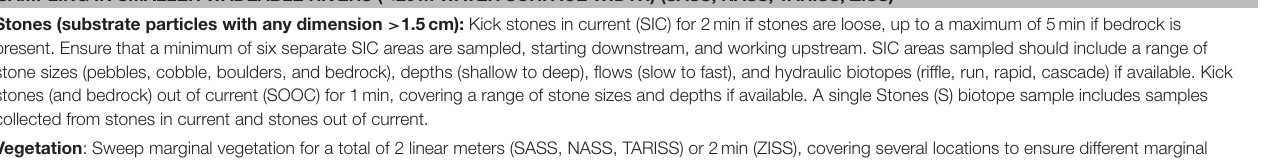
TABLE 1 | Standardized rapid bioassessment protocol for rivers based on aquatic macroinvertebrates used for South African Scoring System (SASS), Namibian Scoring System (NASS), Tanzania River Scoring System (TARISS), and Zambian Invertebrate Scoring System (ZISS). SAMPLING IN SMALLER WADEABLE RIVERS ( < 20m WATER SURFACE WIDTH) (SASS, NASS, TARISS, ZISS) Stones (substrate particles with any dimension > 1.5cm): Kick stones in current (SIC) for 2min if stones are loose, up to a maximum of 5min if bedrock is present. Ensure that a minimum of six separate SIC areas are sampled, starting downstream, and working upstream. SIC areas sampled should include a range of stone sizes (pebbles, cobble, boulders, and bedrock), depths (shallow to deep), flows (slow to fast), and hydraulic biotopes (riffle, run, rapid, cascade) if available. Kick stones (and bedrock) out of current (SOOC) for 1min, covering a range of stone sizes and depths if available. A single Stones (S) biotope sample includes samples collected from stones in current and stones out of